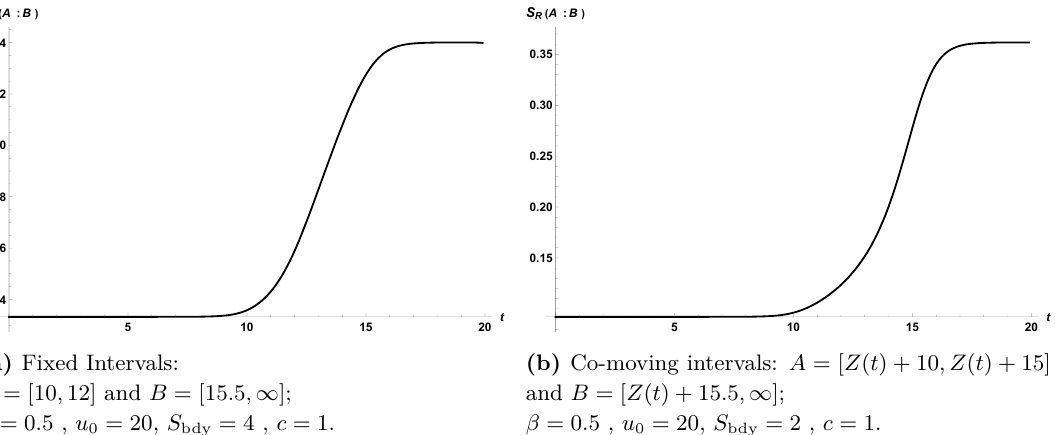
Figure 16. Page curves for the reflected entropy between two disjoint intervals in a kink mirror